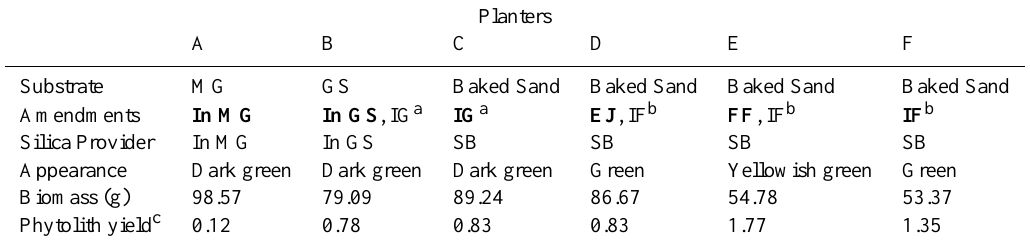
Table 2. Below-ground experiment. Planters’ major features: substrates and amendments, living plant appearance, biomass by dwt and phytolith yields. All nutrients and fertilizers were administered in aqueous solutions, except for MG. In bold: main